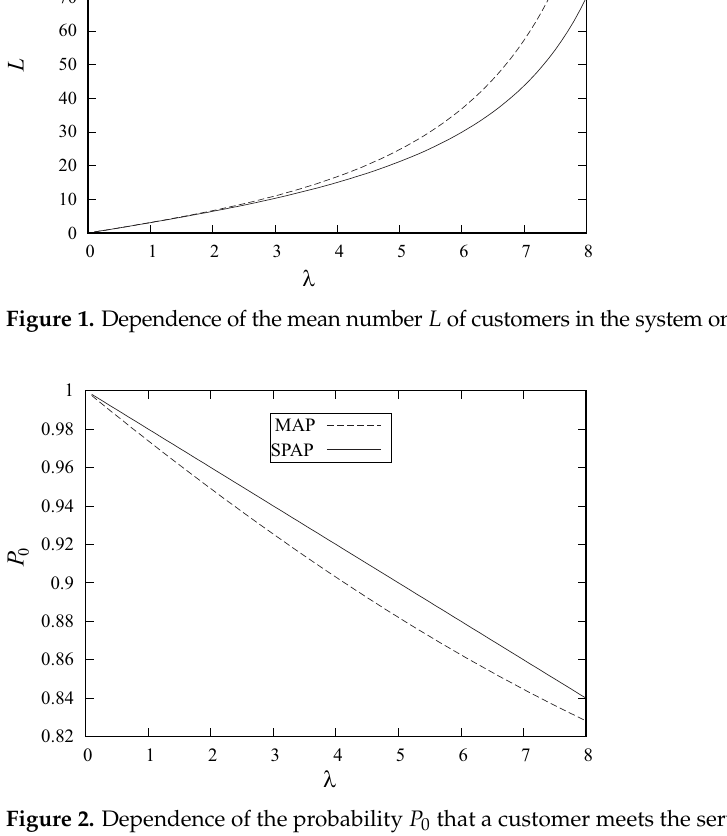
Figure 2. Dependence of the probability P 0 that a customer meets the server, having status 0 (being on vacation) upon arrival, on the average arrival rate λ